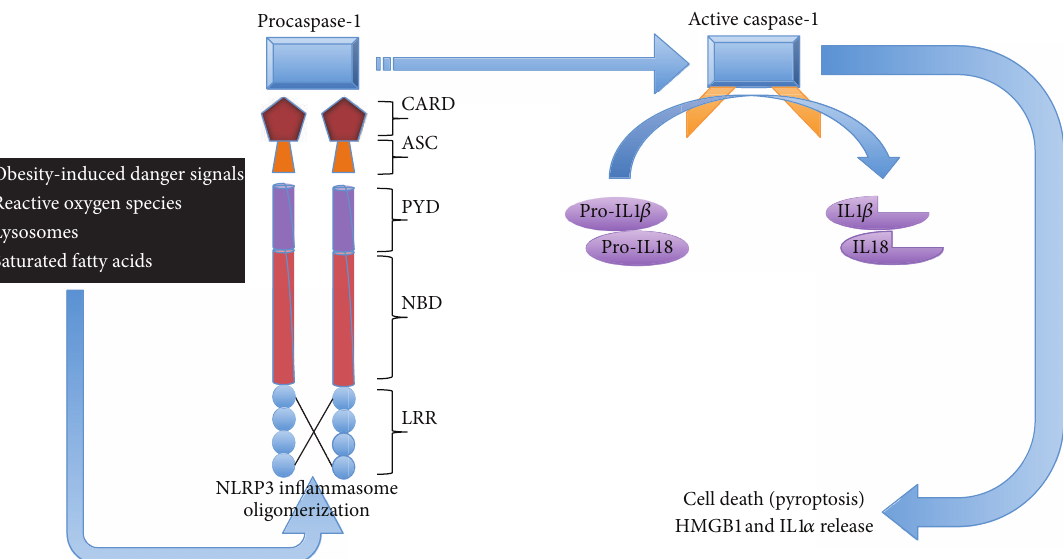
Figure 1: The release of obesity-related danger signals such as reactive oxygen species, lysosomes, and other obesity-induced danger signals resulting in the oligomerization of NLRP3 in adipose tissue. The NLRP3 inflammasome is made up of carboxy terminal leucine-rich repeats (LRRs), a nucleotide-binding domain (NBD), and an N-terminal pyrin domain (PYD). The resulting oligomerization causes the recruitment of procaspase-1 via homotypic binding of caspase activation and recruitment domain (CARD) or through the PYD by means of the adapter apoptosis-associated speck-likeprotein containing a CARD (ASC).Caspase-1isthereforeactivated and initiatesthecleavage of prointerleukin (IL)1 𝛽 and pro-IL18 to form the active cytokines IL1 𝛽 and IL18. The activation of caspase-1 also results in pyroptosis (a form of lytic cell death during inflammation) and the release of high mobility group box 1 (HMGB1) and IL1 𝛼